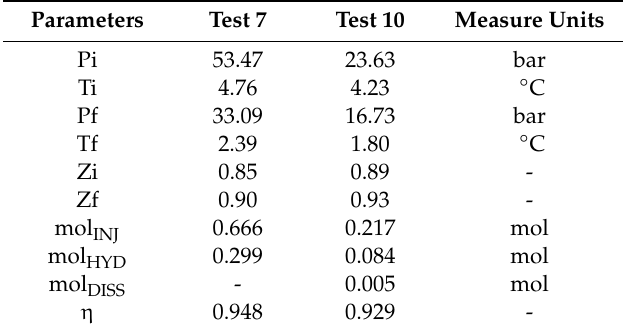
Figure 9. Comparison between Test 9, carried out using CH 4 , and Test 12, performed with CO 2 . Table 4. Parameters related to Test 7 (with CH 4 ) and Test 10 (with CO 2 ).